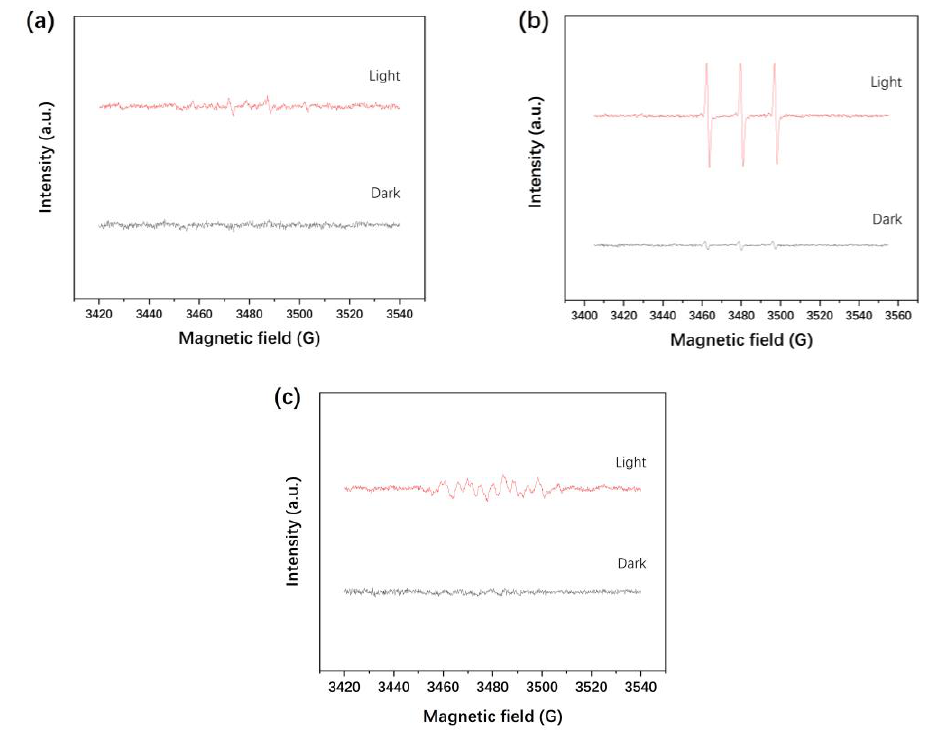
Figure 8. The ESR spetra of DMPO- ‧ OH ( a ), the ESR spetra of TEMP- 1 O 2 ( b ), and the ESR spetra of DMPO- ‧ O 2 − ( c ) (the sample is 1.0%Ag/BiOBr 0.85 I 0.15 irradiated under the xenon lamp light for 80 s). DMPO- · O 2 − ( c ) (the sample is 1.0% Ag/BiOBr 0.85 I 0.15 irradiated under the xenon lamp light for 80